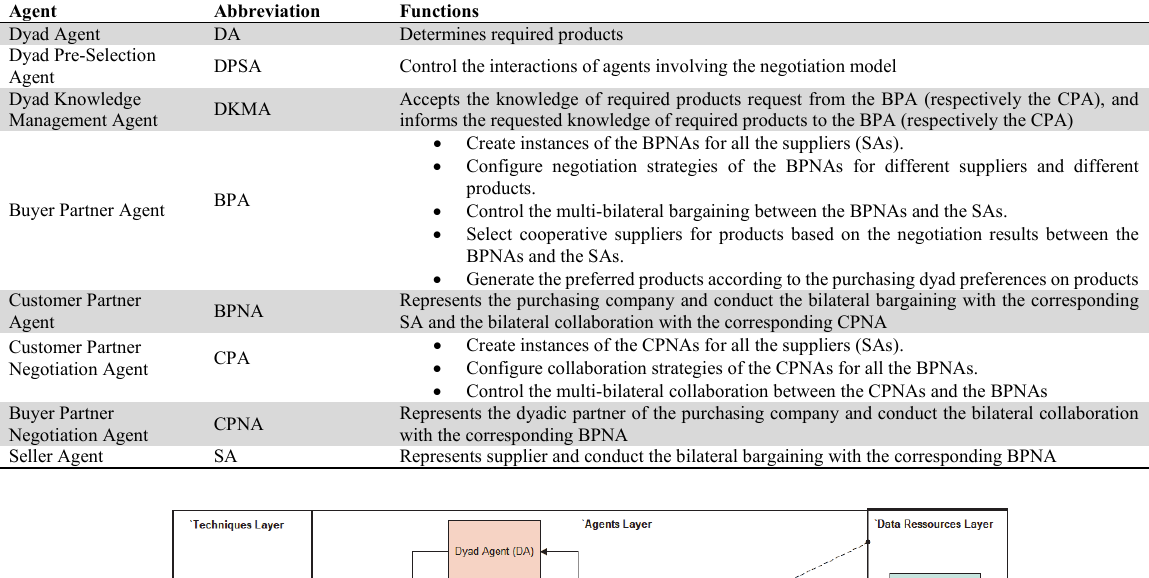
Agent types in the proposed model